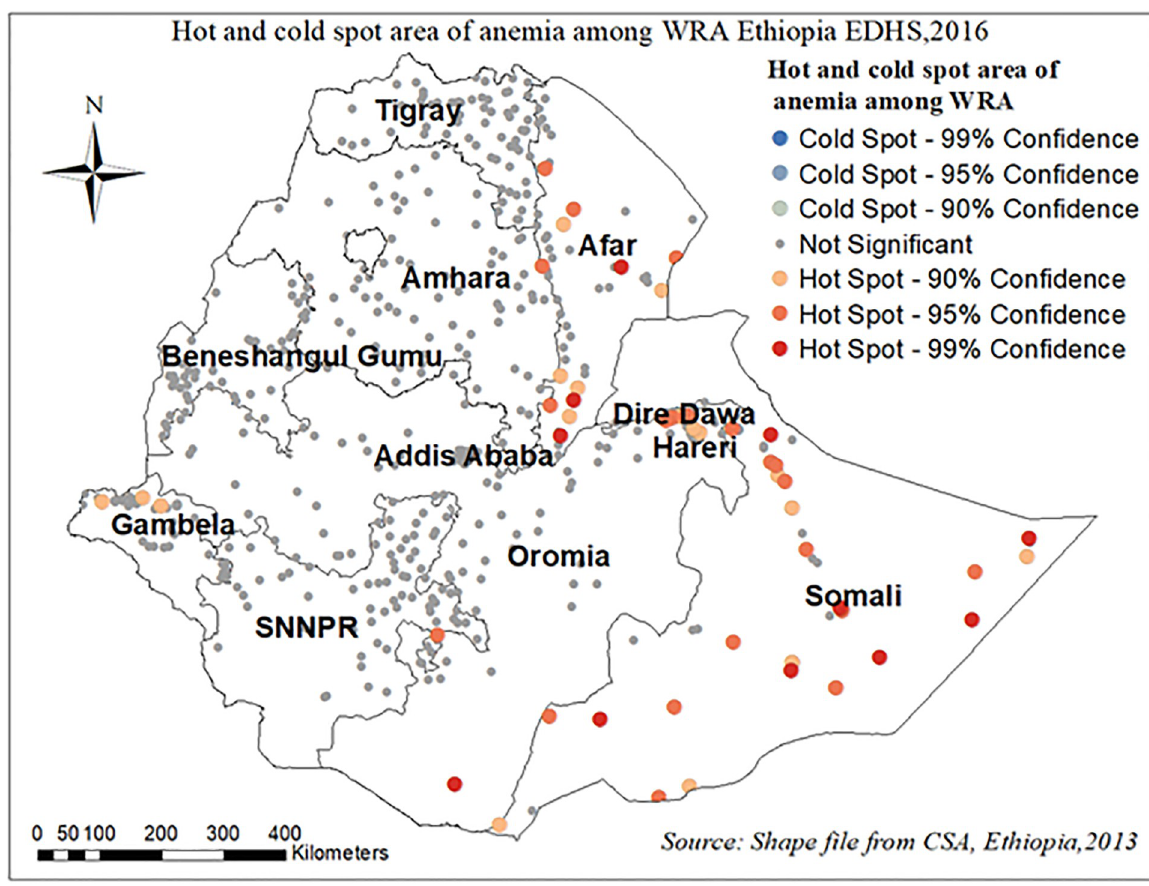
Fig 7. Hot and cold spot area of anemia among reproductive age women in Ethiopia, EDHS 2016. https://doi.org/10.1371/journal.pone.0274995.g007 Table 4. Primary and Secondary SaTScan analysis result of anemia among reproductive-age women in Ethiopia Ethiopian demographic and health survey 2016. Cluster Enumeration area identified Coordinate/radius Population cases RR LLR